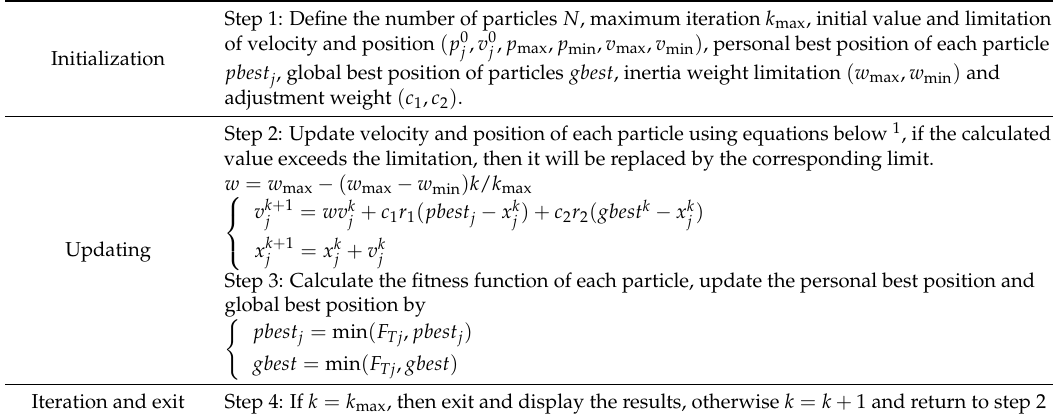
Table 2. Major steps of particle swarm optimization (PSO)